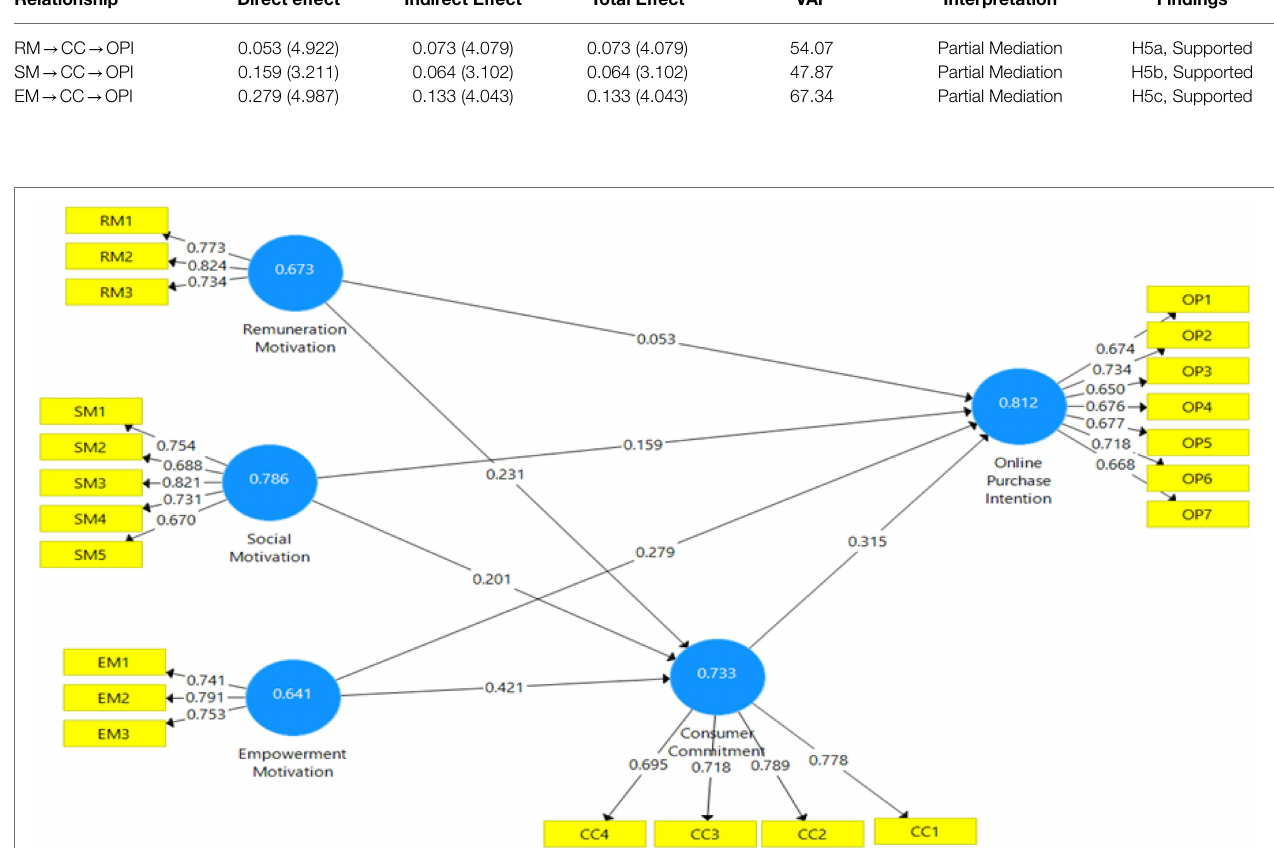
TABLE 2 | Mediation effects.